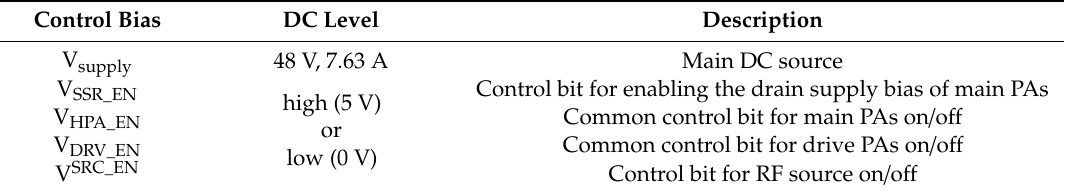
Table 1. DC control bias description.